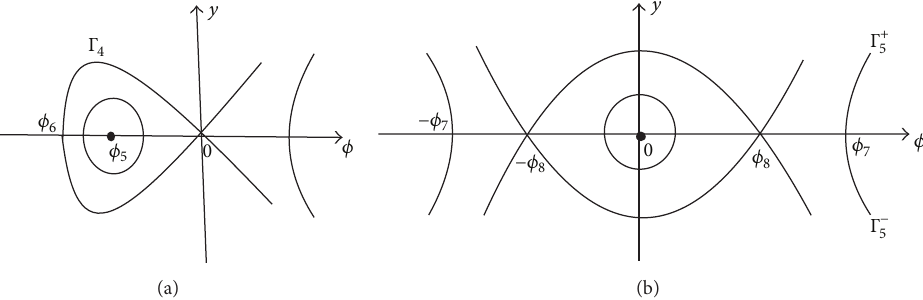
Figure 3: The phase portraits of Sy. (16). (a) For 𝑝 > 𝑞 , 𝑝 − 𝑞 is odd and 𝑐 > 0 . (b) For 𝑝 > 𝑞 , 𝑝 − 𝑞 is even and 𝑐 > 0